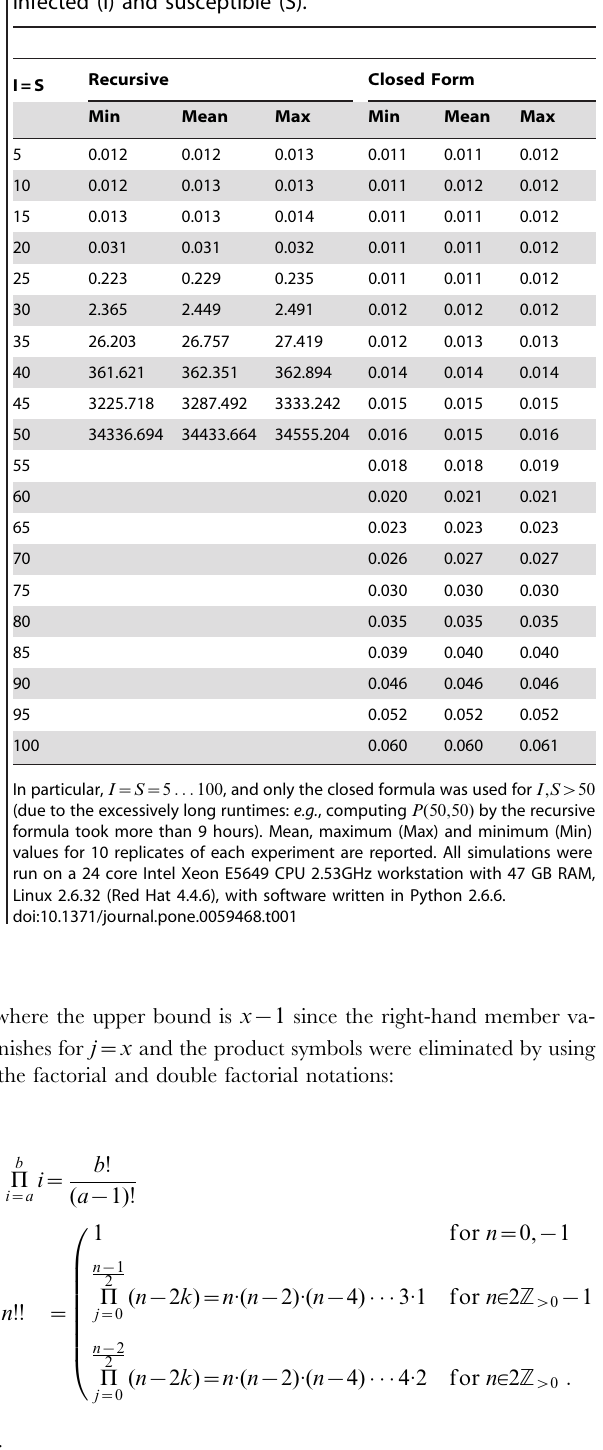
Table 1. Computing times (in seconds) required to compute P ( I , S ) by the recursive formula in Eq. 1 and the equivalent closed formula in Eq. 2, for different values of the number of infected (I) and susceptible